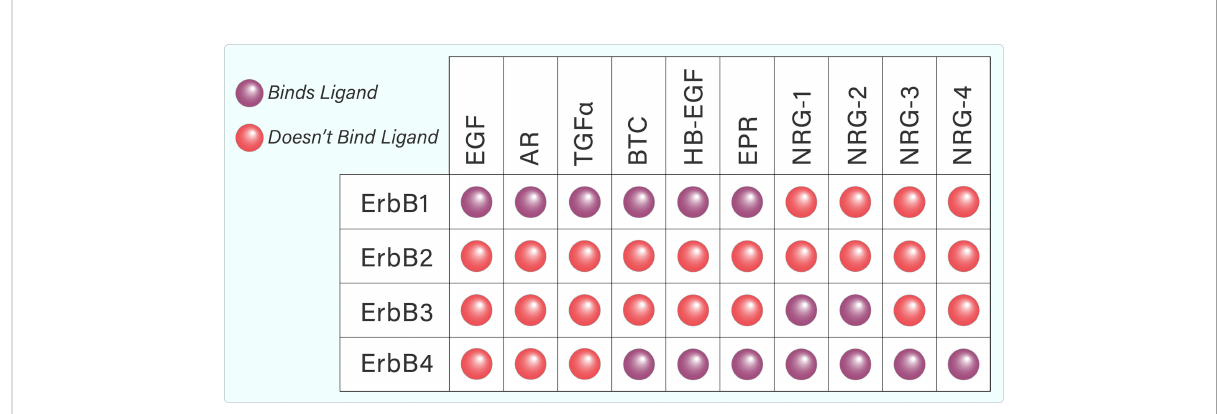
FIGURE 2 Tabular representation of ErbB ligand binding. ErbB1, 3, and 4 are capable of binding several ligands while ErbB2 does not appear to bind any known